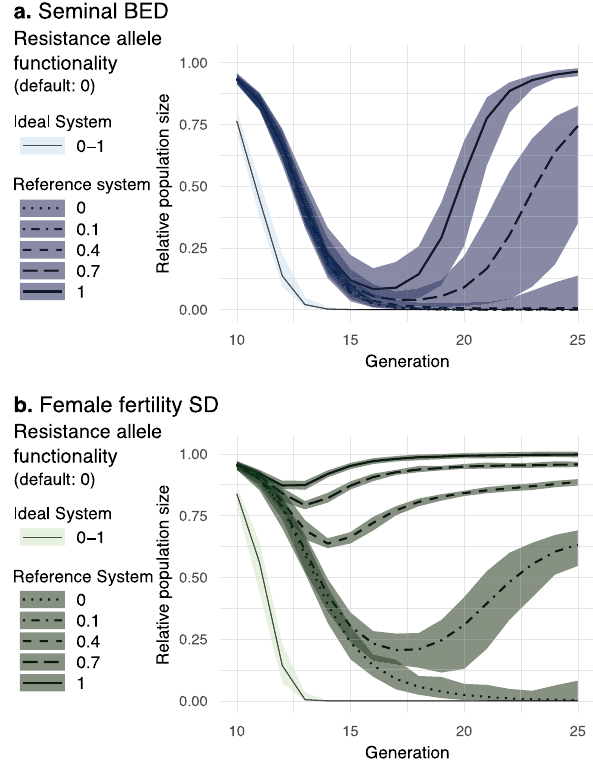
Figure 6. Impact of Resistance allele functionality . Relative population size from generation 10 to 25 is shown with ideal and reference drive parameters for sBED ( a ) and ffSD ( b ) using in each case different values of Resistance allele functionality . Lines represent the 100-simulations mean value while the colored envelopes stand for the maximum and minimum